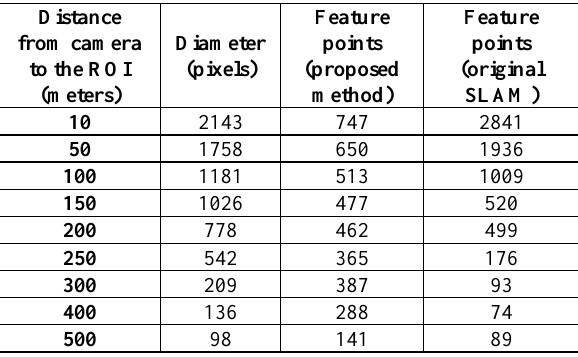
Figure 6 . Output of the MASK-R CNN detector under different conditions of scale, rotation, lighting and occlusion: Bounding boxes out of the mask shapes with confidence value. Wrong predictions are highlighted with red. Table 3. The number of feature points detected in the last frame of each sequence for different camera distances. The focal length is 5.58 mm for a resolution of 1080 x 2400